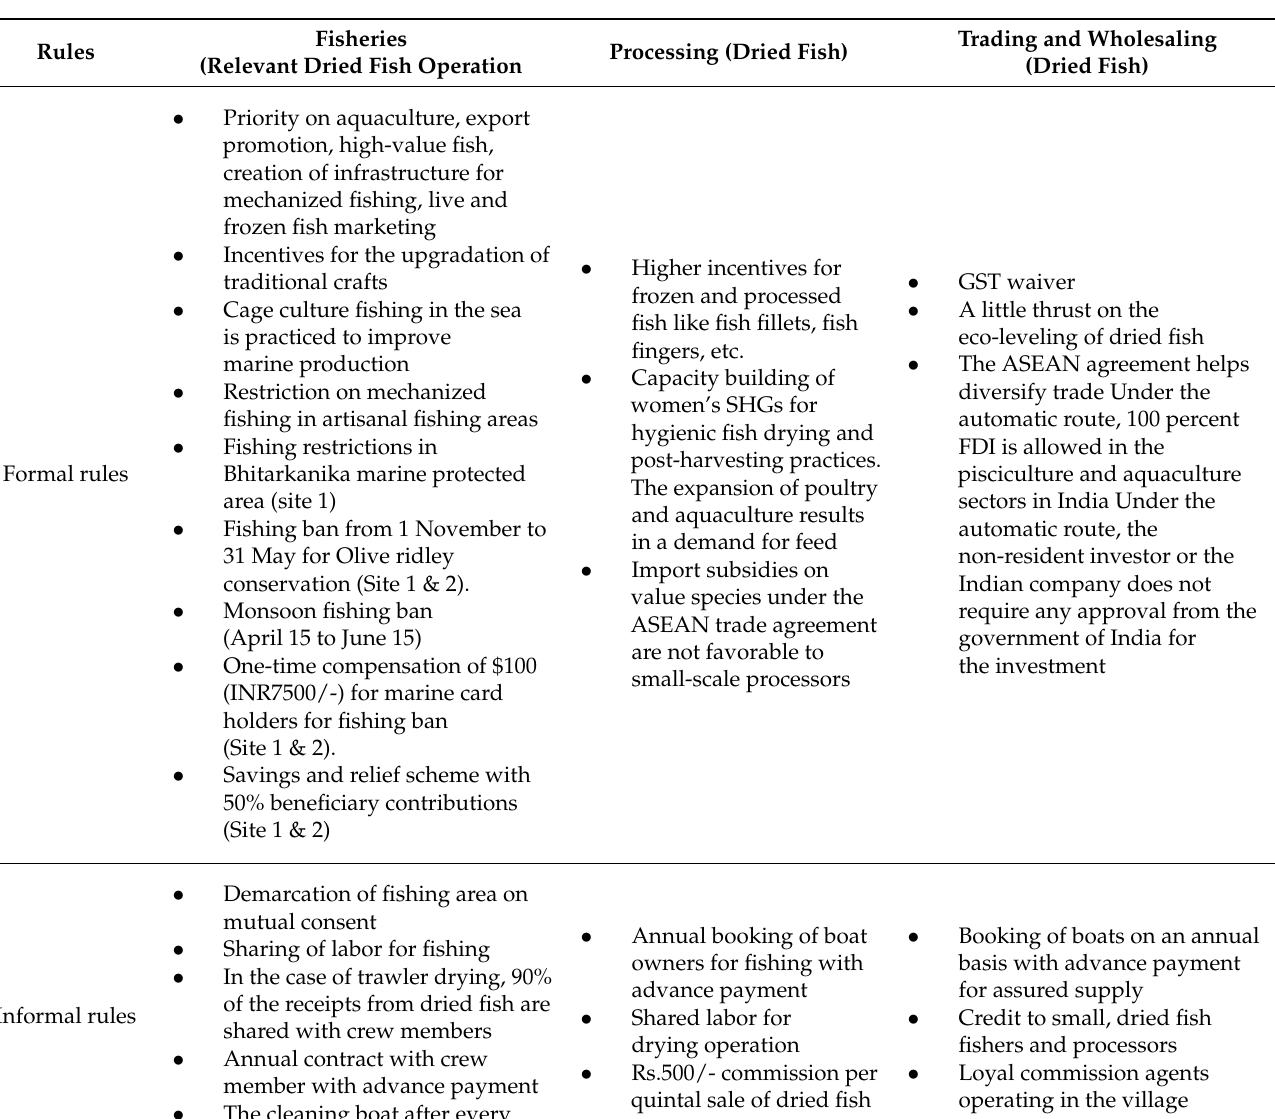
Table 4. An overview of formal and informal rules that influence different nodes of